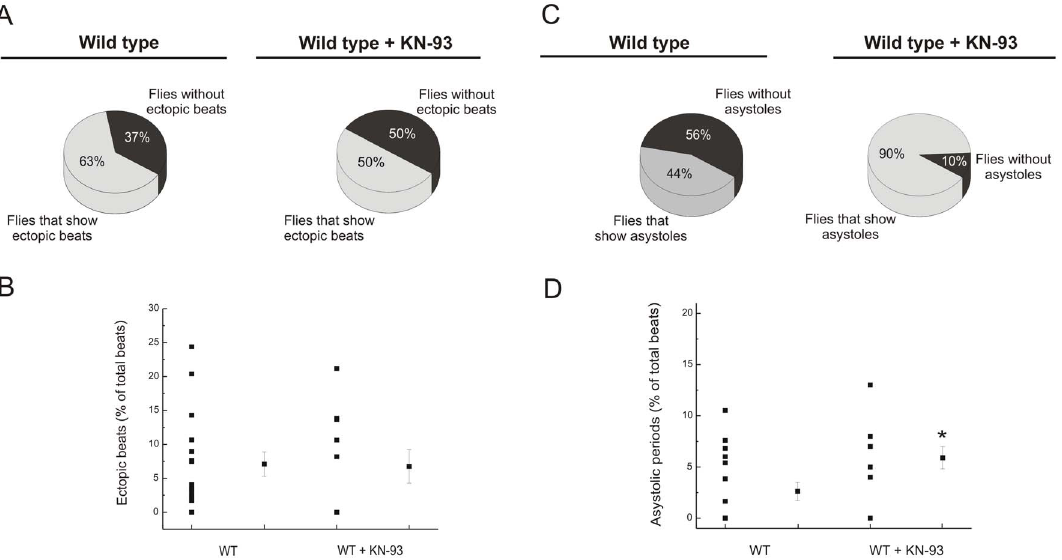
Figure 6. CaMKII inhibition does not modify the occurrence of ectopic beats but increased the incidence of asystoles. Inhibition of CaMKII did not change significantly the number of individuals that exhibited ectopic beats (A) neither the percentage of ectopics beats over total beats (B). The number of flies that showed asystoles was greater with CaMKII inhibition (C). The percentage of asystoles in these flies referred to the total beats, was significantly different from observations without KN-93 (D). Mean 6 SEM of 24 flies. *p # 0.05.